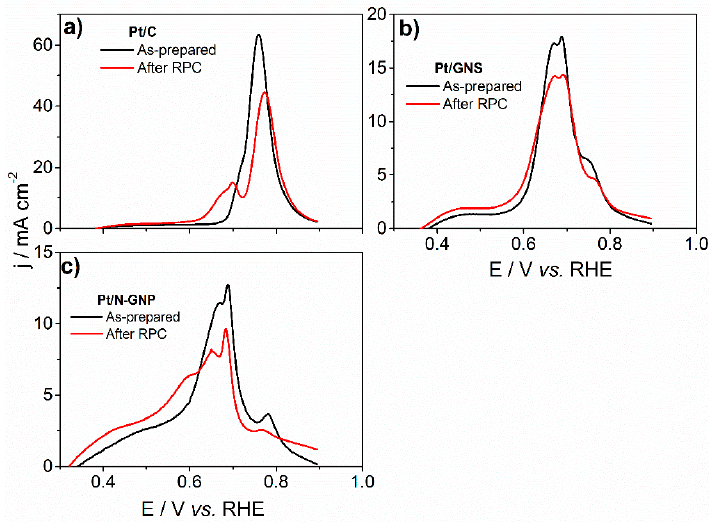
Figure 5. CO oxidation on as-prepared and cycled Pt / C ( a ), Pt / GNS ( b ), and Pt / N-GNP ( c ). Table 3. Electrochemically active surface area (ECSA) values ECSA loss after RPC of Pt / C, Pt / GNS, and Pt //